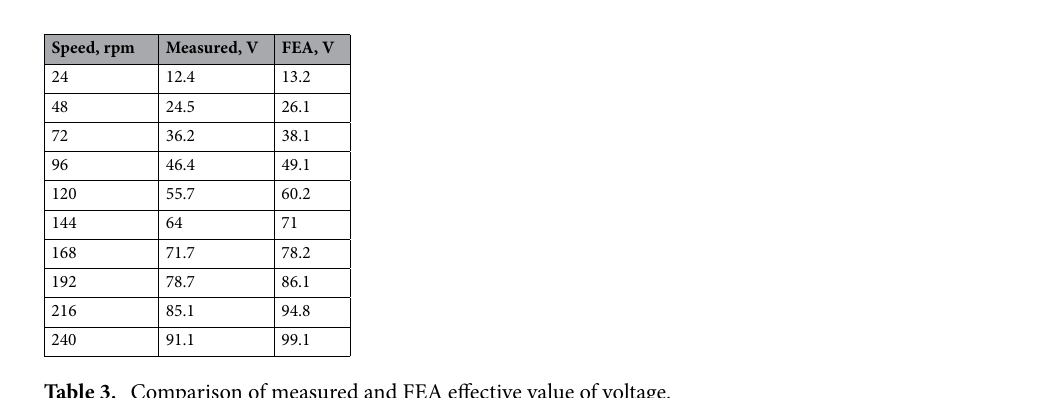
Table 3. Comparison of measured and FEA effective value of